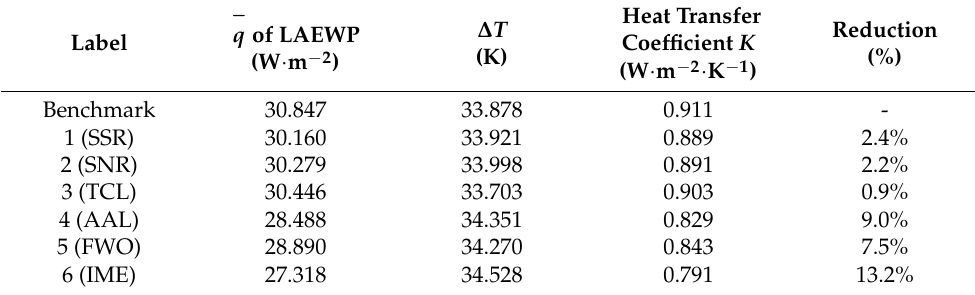
Table 9. Heat transfer coefficient of univariate improvement approaches.